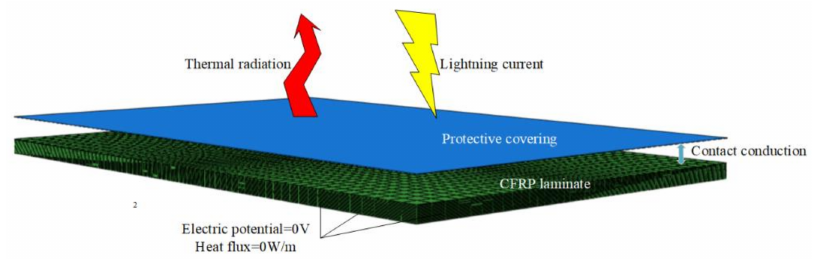
Figure 3. Conditions settings of the FEA